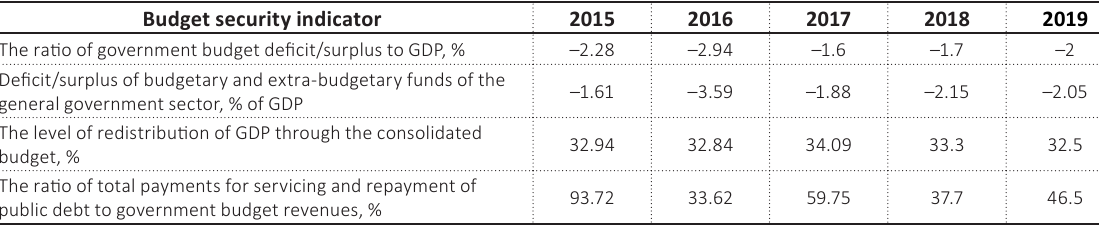
Table 2. Ukraine’s budget security indicators in 2015–2019 Budget security